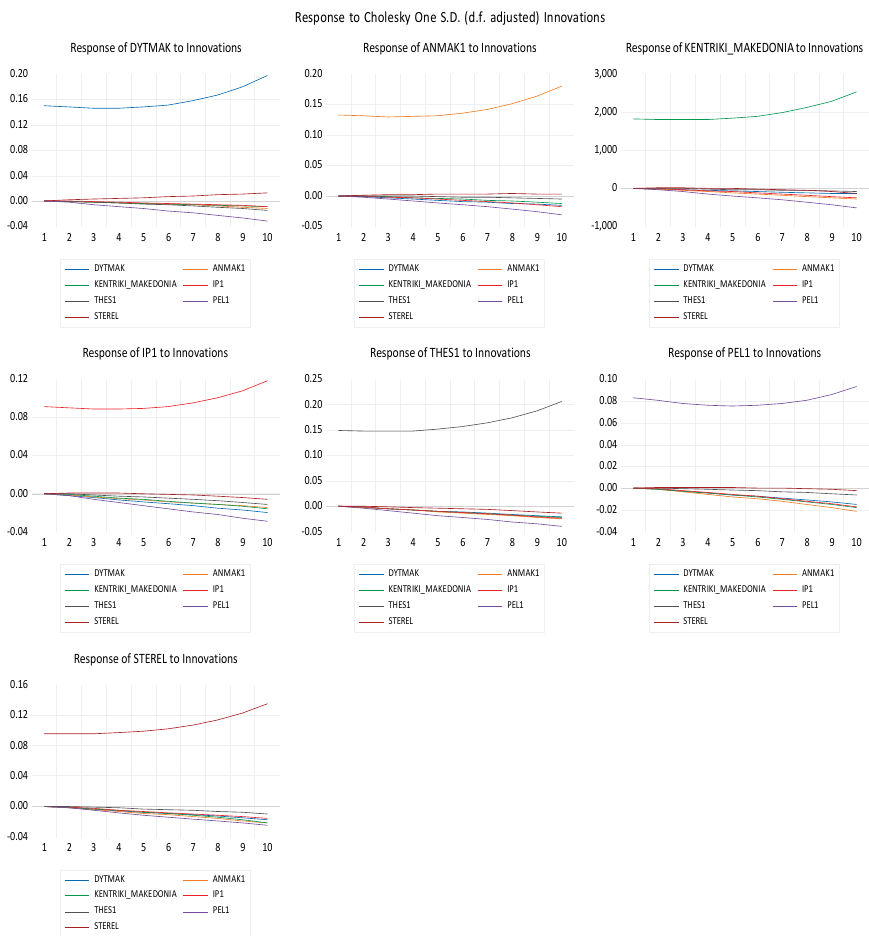
Figure 4. Impulse response analysis. (Source NSI own elaboration).